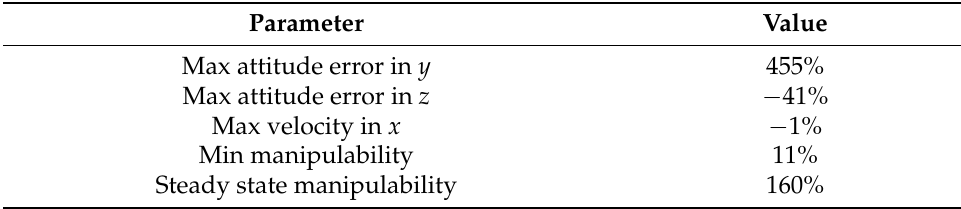
Table 4. Percentage